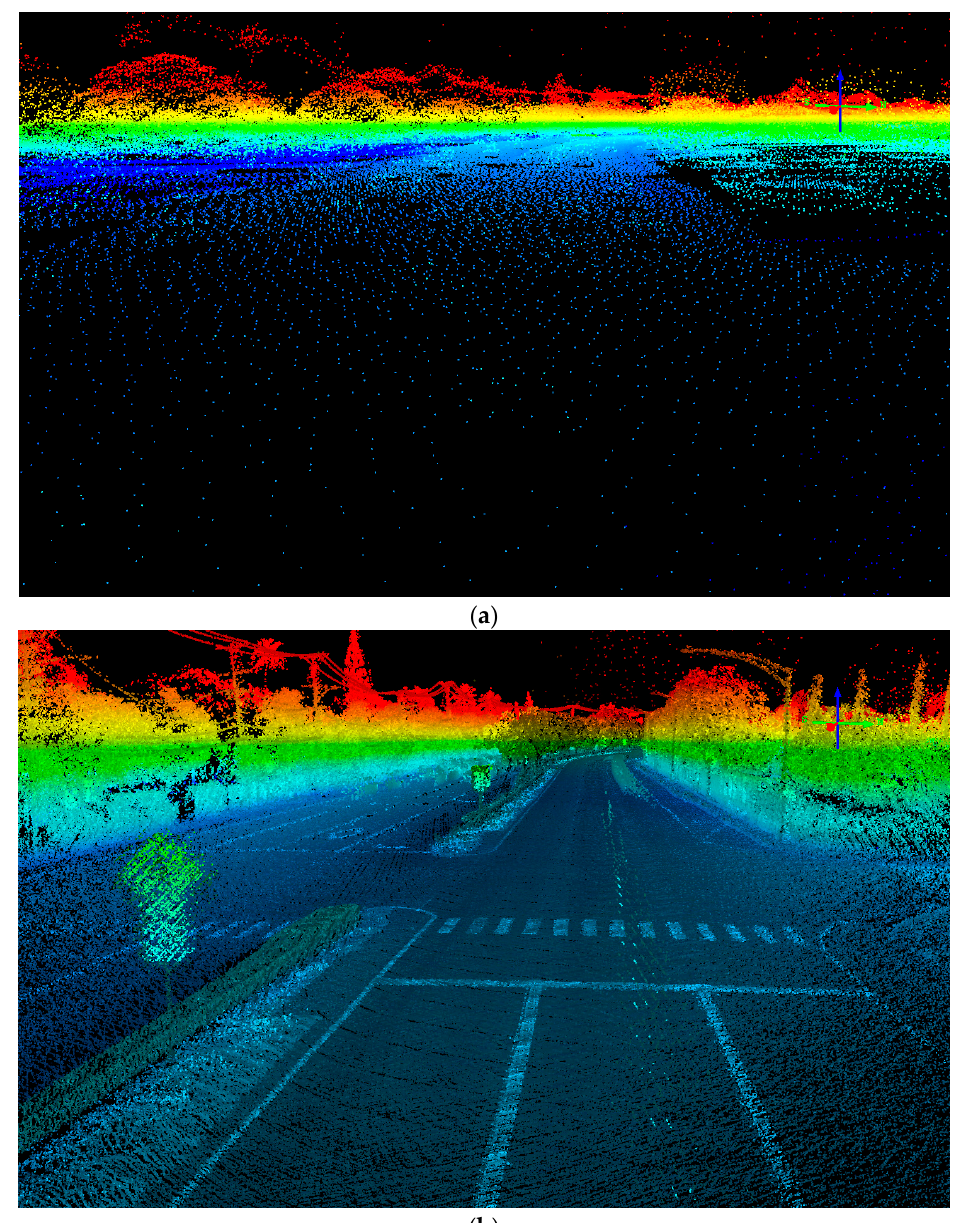
Figure 2. Comparison of airborne and mobile LiDAR data of the same area. ( a ) Airborne LiDAR (ALS = airborne laser scanning); ( b ) mobile LiDAR (MLS = mobile laser scanning).